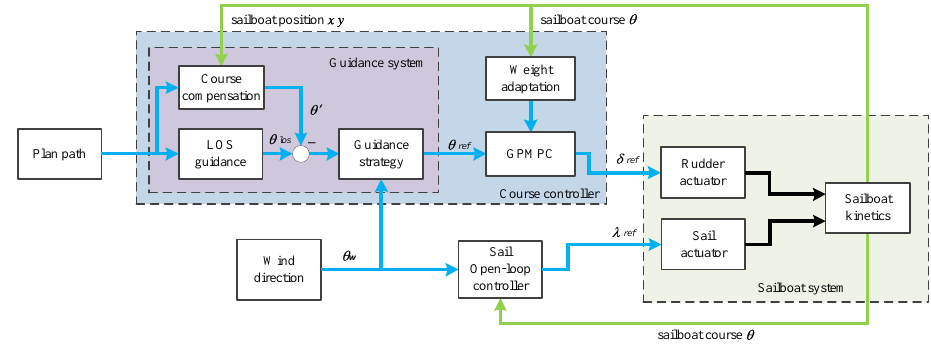
Figure 2. The control architecture of the sailboat. It includes the sailboat system on the right side, the course control system on the upper side, and the speed controller on the lower